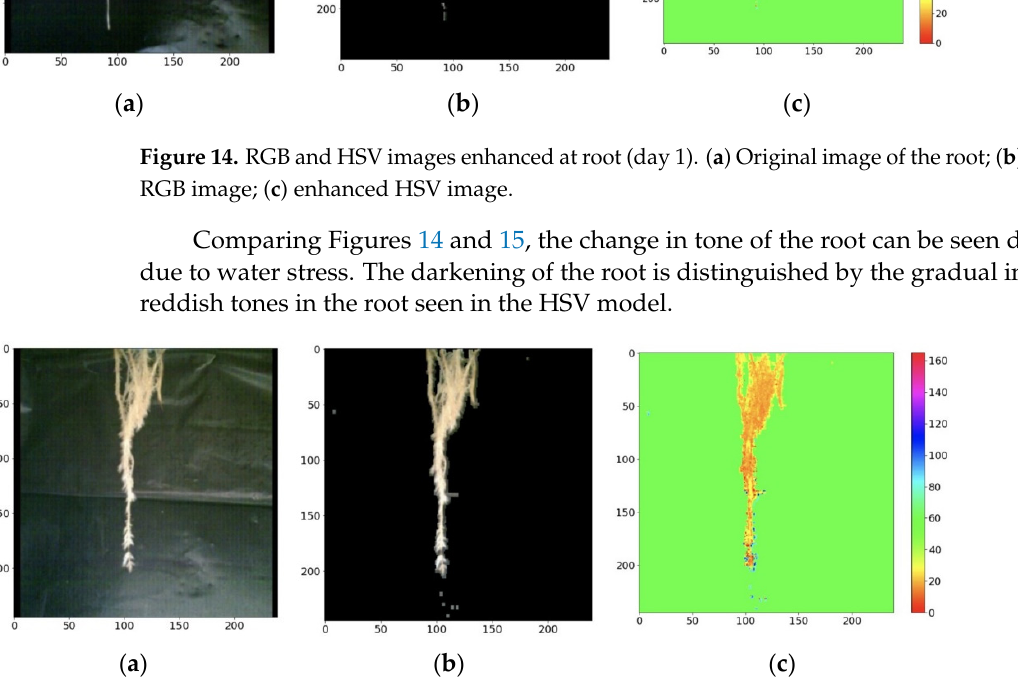
Figure 15. RGB and HSV images enhanced at root (day 7). ( a ) Original image of the root; ( b ) enhanced RGB image; ( c ) enhanced HSV image.